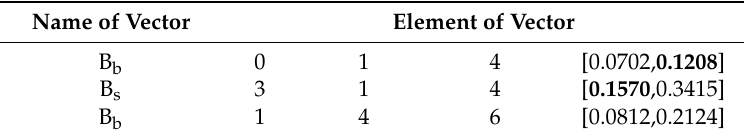
Table 6. Identification template 2 for forest class.